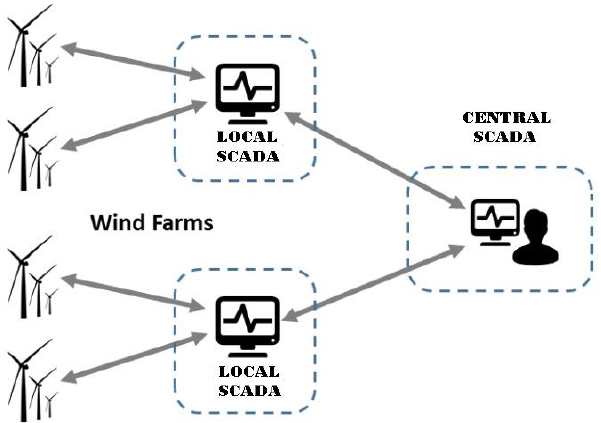
Figure 8. Application of a preventive control scheme for local and systemic actions.